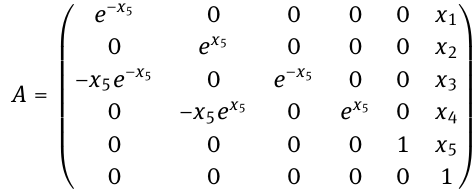
Formality Lefschetz